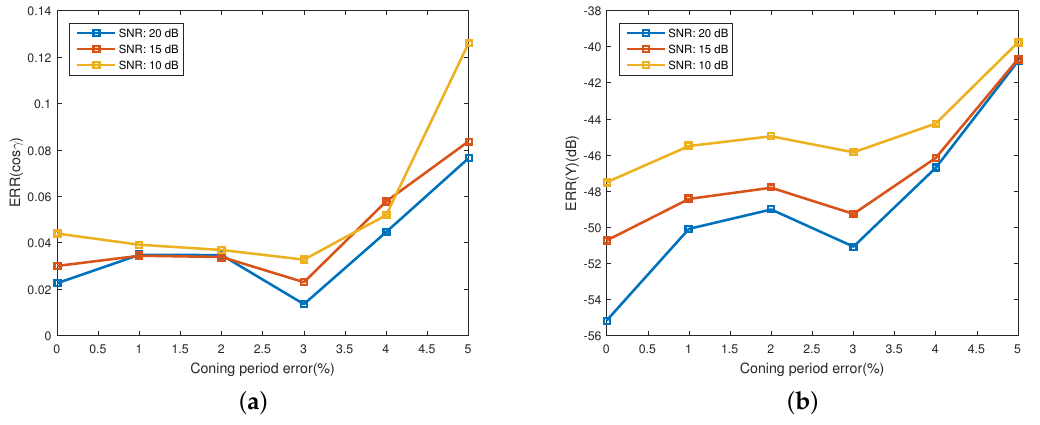
Figure 9. Estimating error of the projecting feature at different error of the estimated coning period. ( a ) shows the estimating error of the observing angles; and ( b ) depicts the estimating error of the corresponding emissivity-area products.